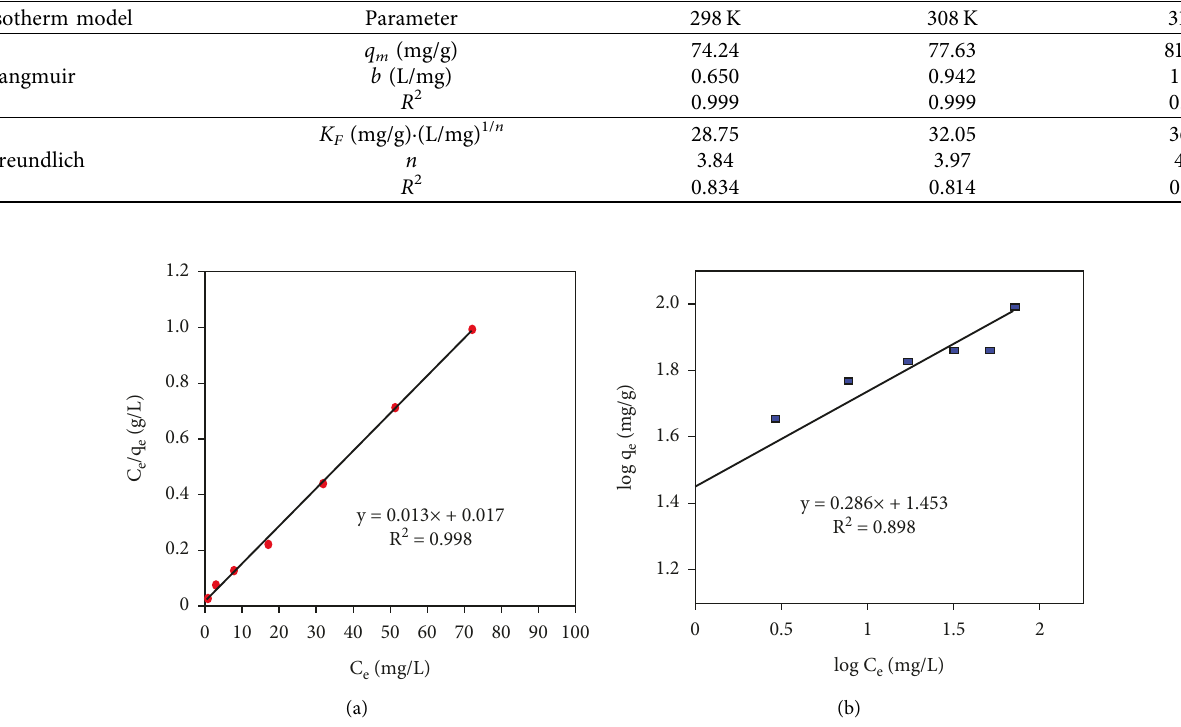
Figure 9: (a) Langmuir, and (b) Freundlich plots for Cr(VI) biosorption using CADSP at 298 K.